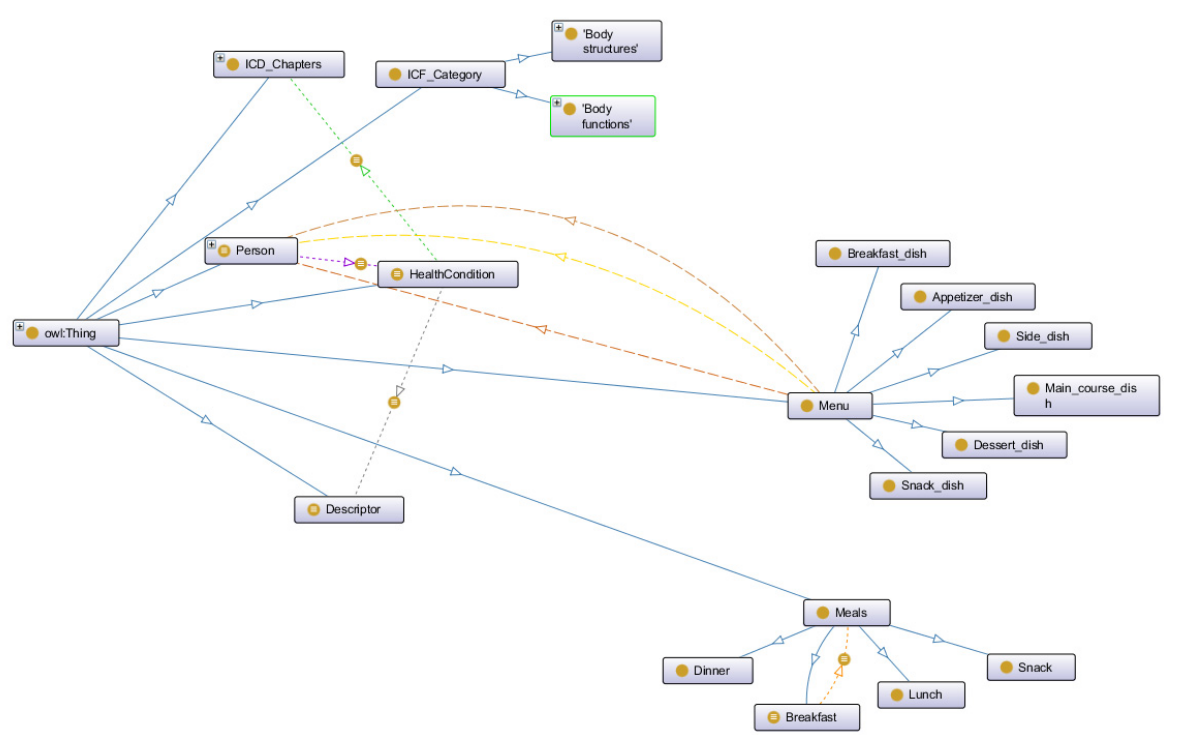
Figure 3. A graphical representation of an excerpt of the HeNuALs ontology, developed with the Protégé ontology editor [41].